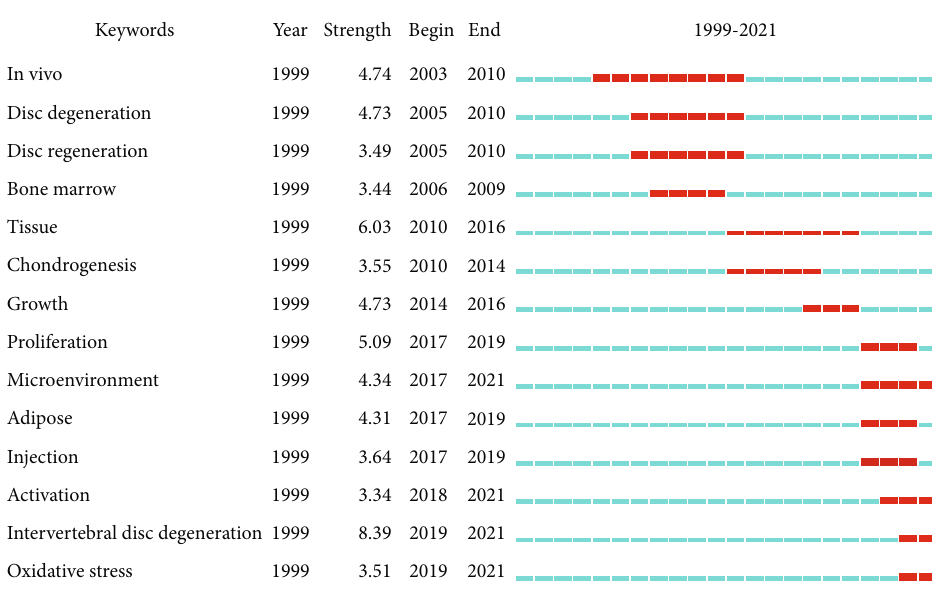
Figure 8: Top 14 keywords with the strongest citation bursts on stem and progenitor cells in intervertebral